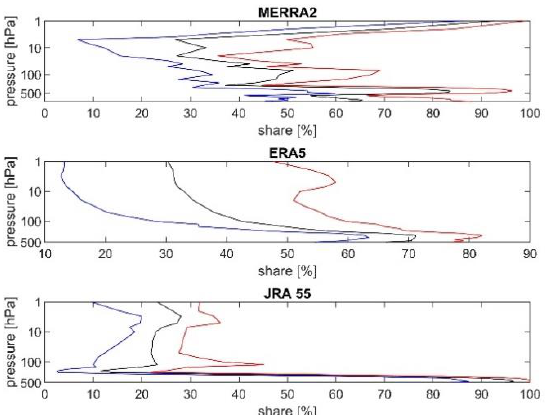
Figure 2. Vertical profile of average (black), minimal (blue) and maximal (red) share of discontinuities to all grids from all months from the Pettitt test for MERRA-2 ( upper panel ), ERA-5 ( middle panel ), and JRA-55 ( lower panel ).